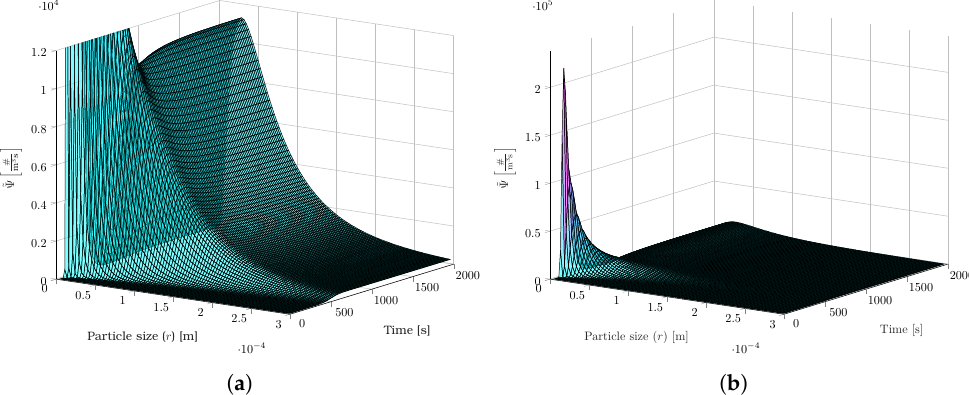
Figure 14. ( a ) Full scale; ( b ) zoomed scale of the particle distribution in the case of the non-isothermal continuous system.